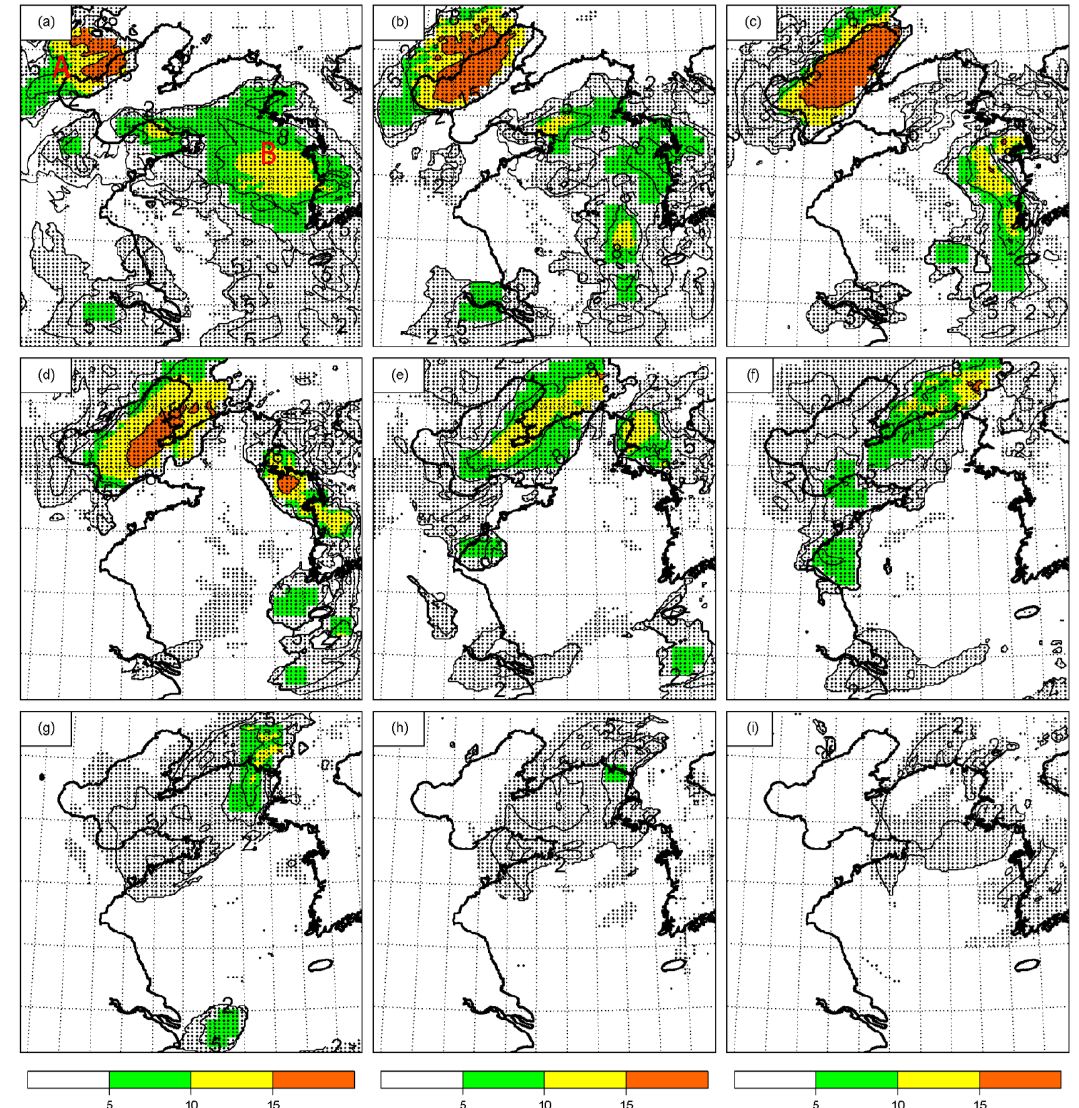
Figure 8. ( a – i ) Two Coastal Low Level Jets (LLJ) A and B simulated in a constrained COSMO-CLM simulation with a grid resolution of 7 km, forced by ERA-Interim with three-hourly increments starting from 1 April 2006. The dotted area features maximum wind speed larger than 10 m/s at height below ~3 km, the colored area stands for low level jets, with differences between the wind maximum and minimum larger than or the wind speed at ~3 km greater than 5 m/s. LLJ A: Starting from weak